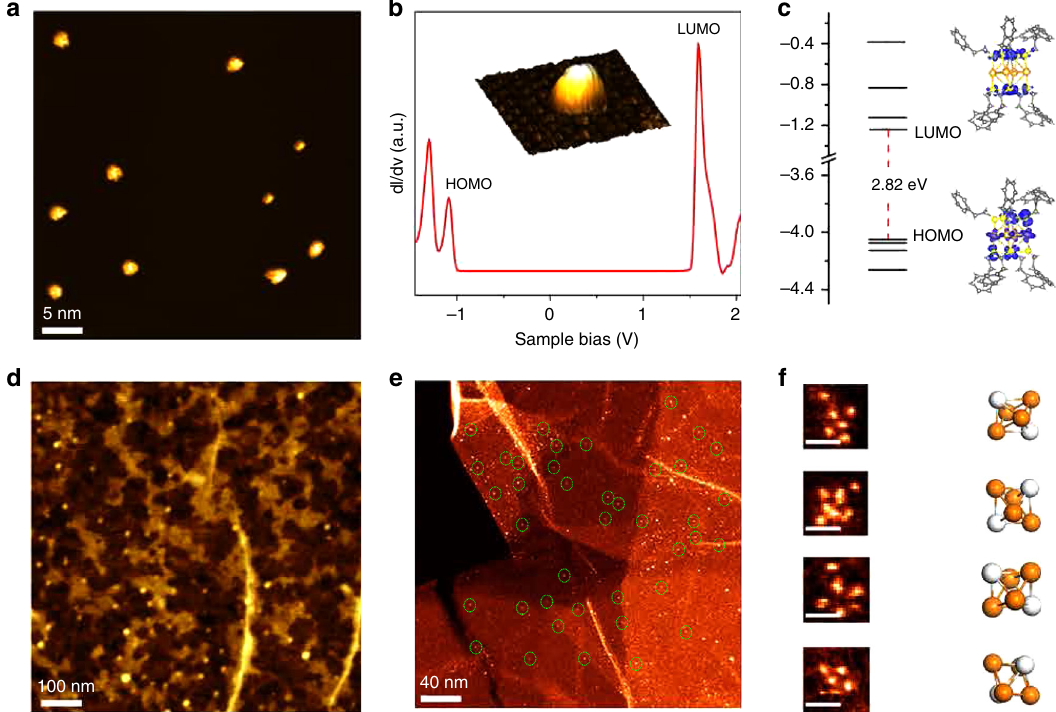
Fig. 2 Basic characterization of Au 4 Pt 2 (SR) 8 . a Representative STM image of Au 4 Pt 2 (SR) 8 on a HOPG substrate. b STS pro fi le of single Au 4 Pt 2 (SR) 8 cluster on graphite surface. c Calculated frontier orbitals of single Au 4 Pt 2 (SR) 8 deposited on defective graphene. f High-resolution STEM-ADF images of single Au 4 Pt 2 (SR) 8 clusters and approximate corresponding orientations(scale bars in Fig. 2f are 5 Å). Colors: golden, Au; white, Pt; yellow, S; gray, C. Sulfur, carbon, and hydrogen atoms are omitted for clarity in ( f ).